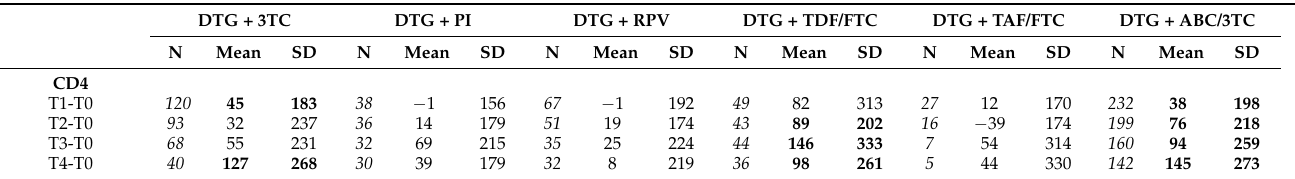
Table 2. CD4 + and CD8 + T cells and CD4/CD8 ratio dynamics in patients in treatment with Dolute- gravir